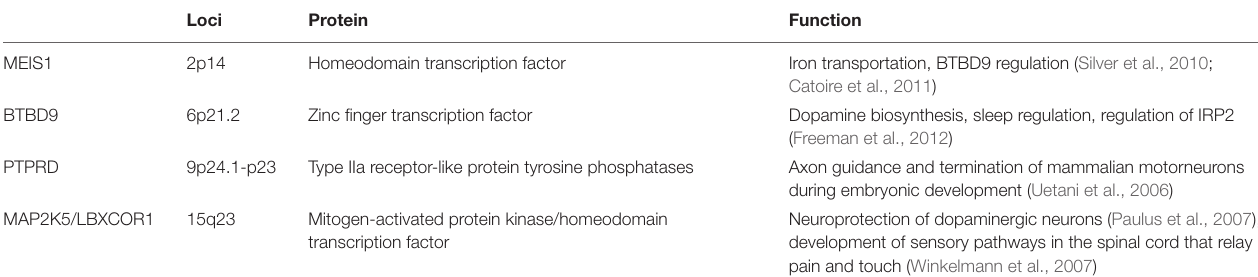
TABLE 3 | Main SNP findings associated with